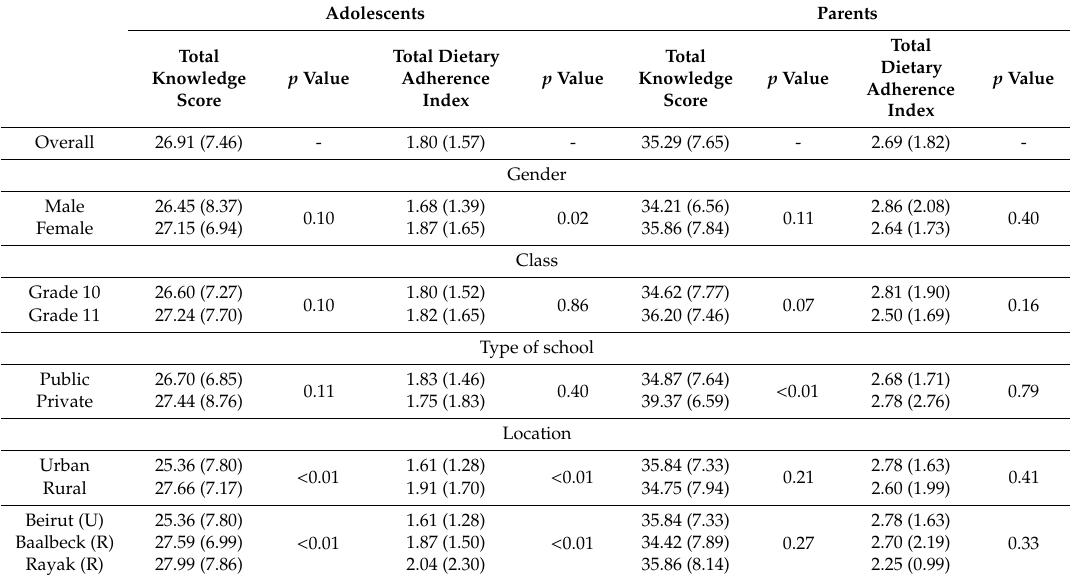
Table 2. Means (SD) and di ff erences in total knowledge and adherence scores among adolescents and their